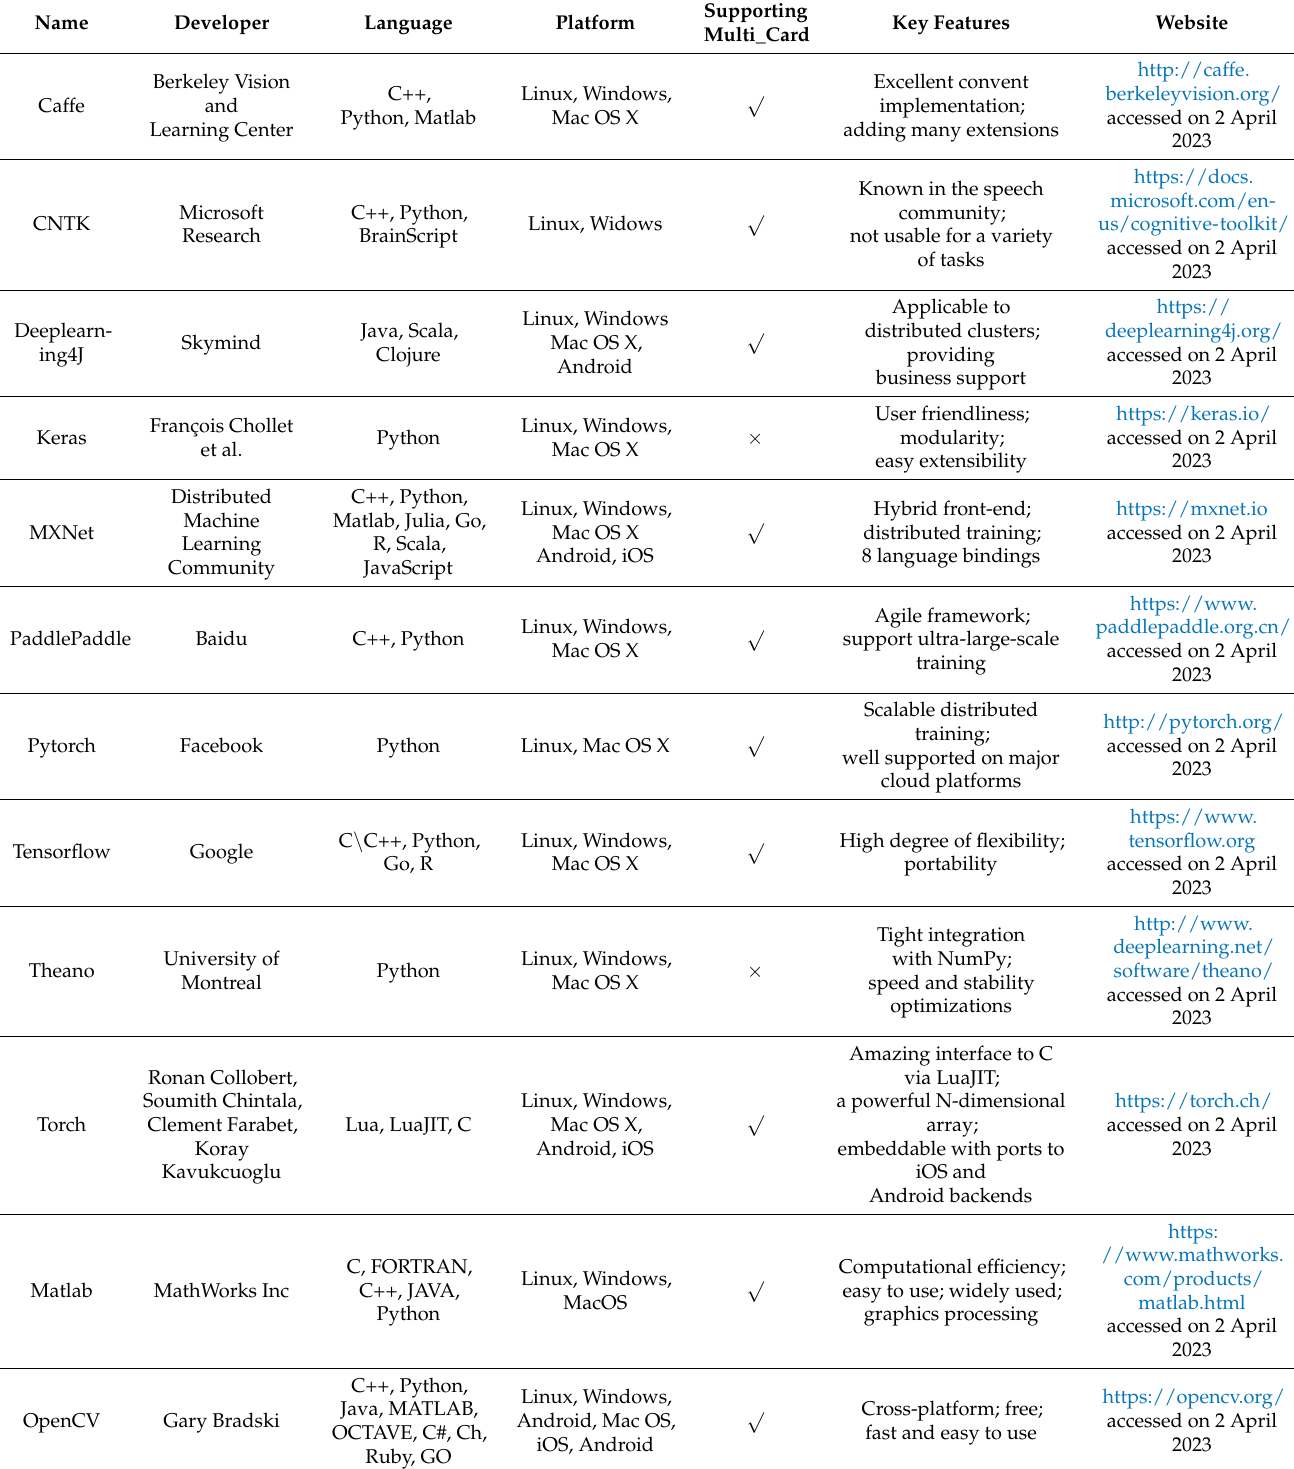
Table 3. Summary of deep learning toolkits for